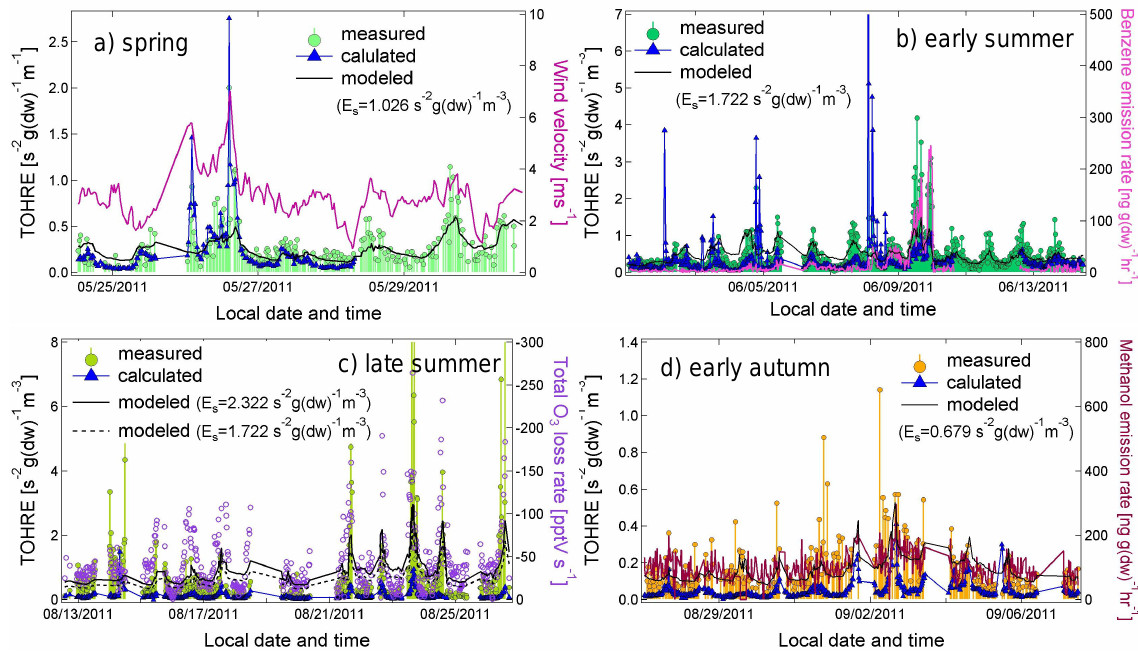
Fig. 9. Each of the graphs (a–d) presents measured, calculated and modeled TOHRE as well as one parameter such as wind velocity, benzene emission rates, total O 3 loss rate and methanol emission